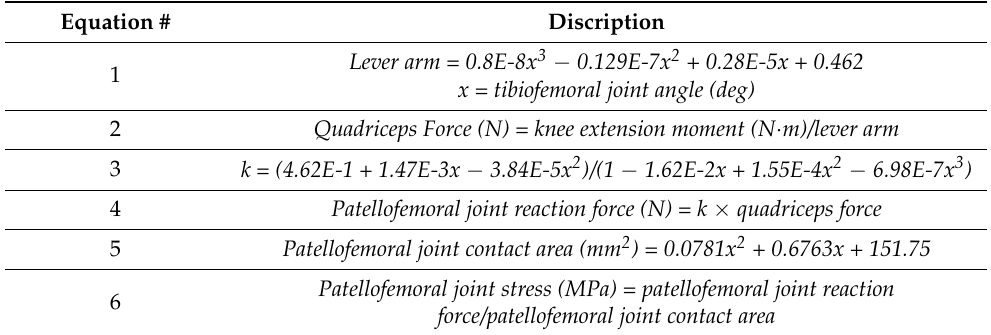
Table 1. Patellofemoral joint stress calculations.